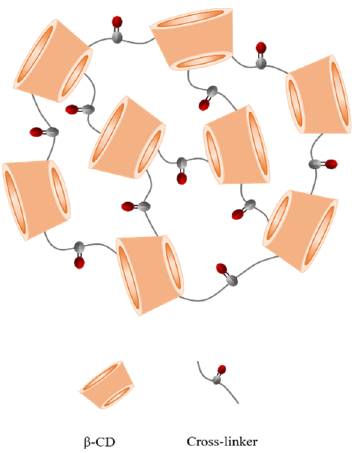
Figure 2. Schematic representation of cyclodextrin nanosponges.